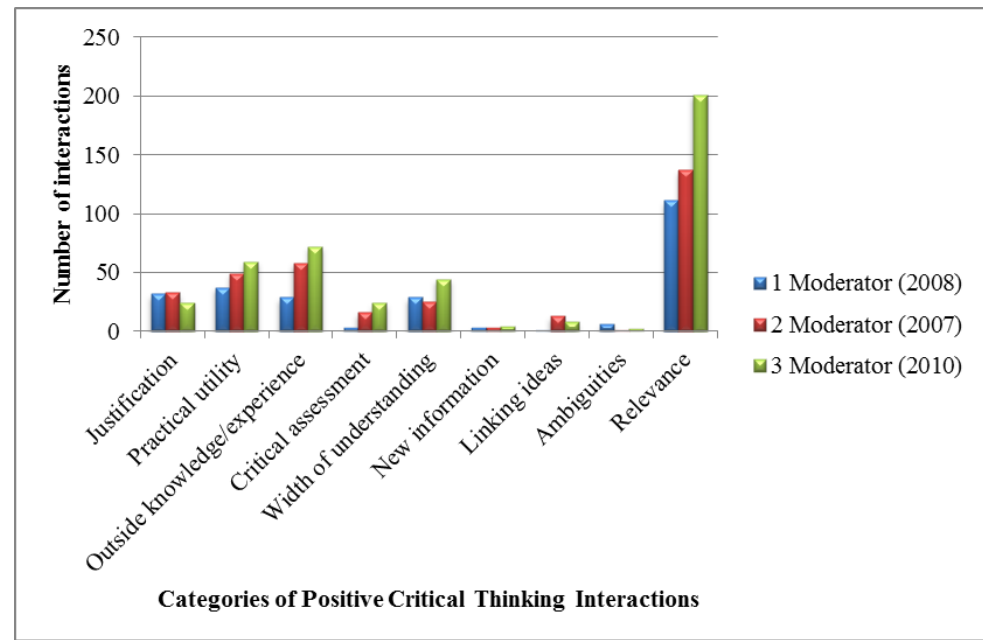
Figure 5. Number ( y axis) and positive critical thinking interactions ( x axis) of 1, 2, and 3 SM groups.